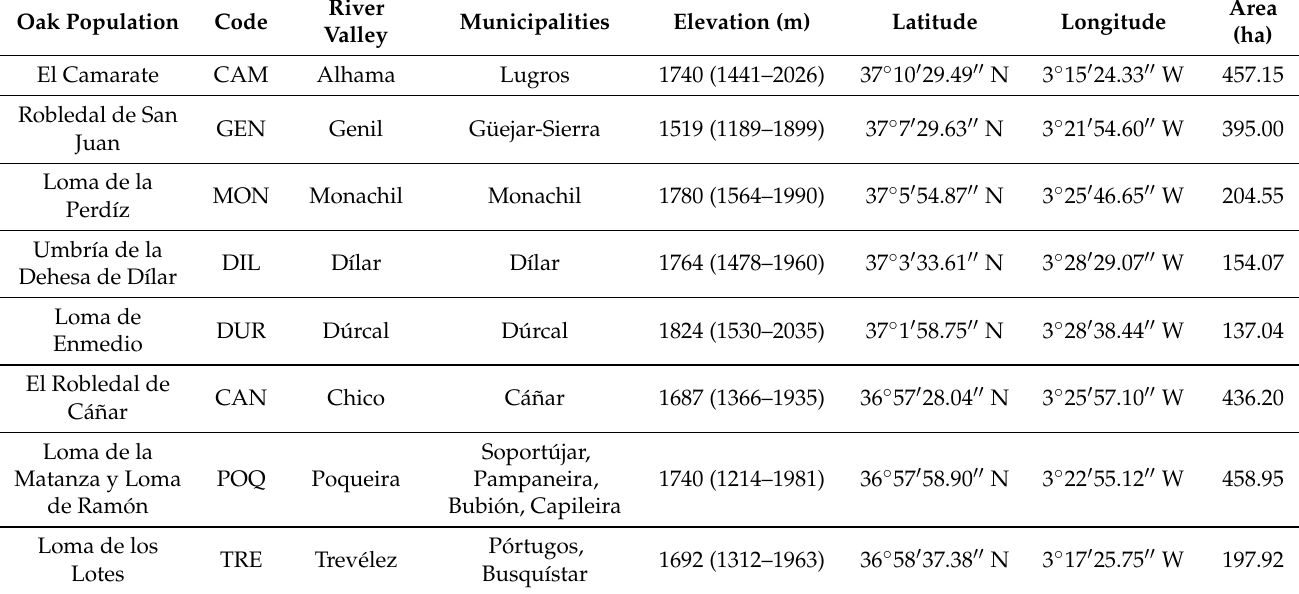
Table 1. Description of the Quercus pyrenaica populations in Sierra Nevada. For elevation, minimum, and maximum values are in brackets. The latitude and longitude coordinates referred to the polygon